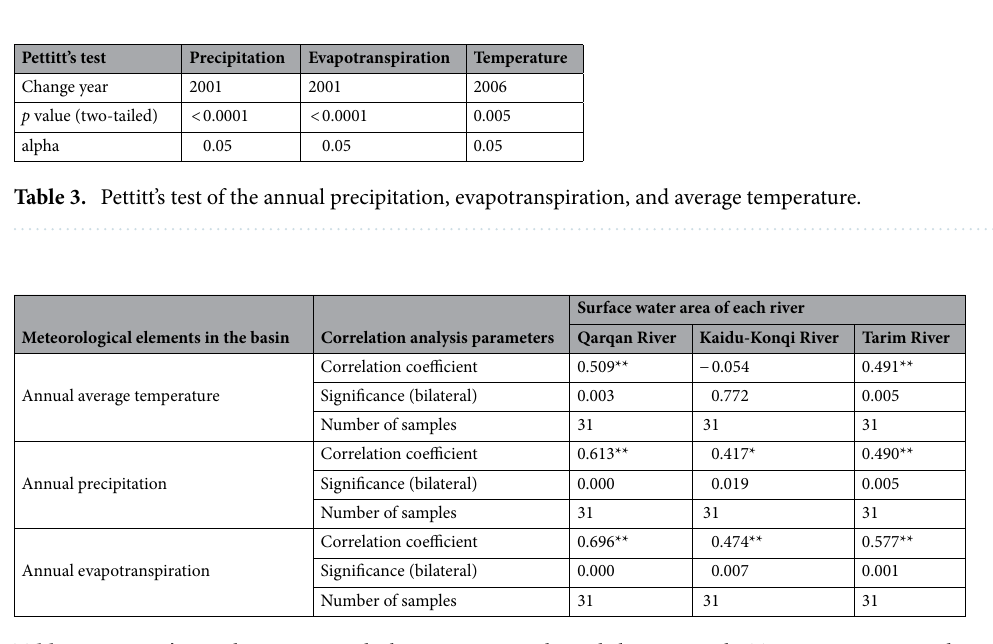
Table 4. Pearson’s correlation test results between meteorological elements in the Tarim River Basin and surface water area of each tributary river. *Significance level with alpha = 0.05, **Significance level with alpha =